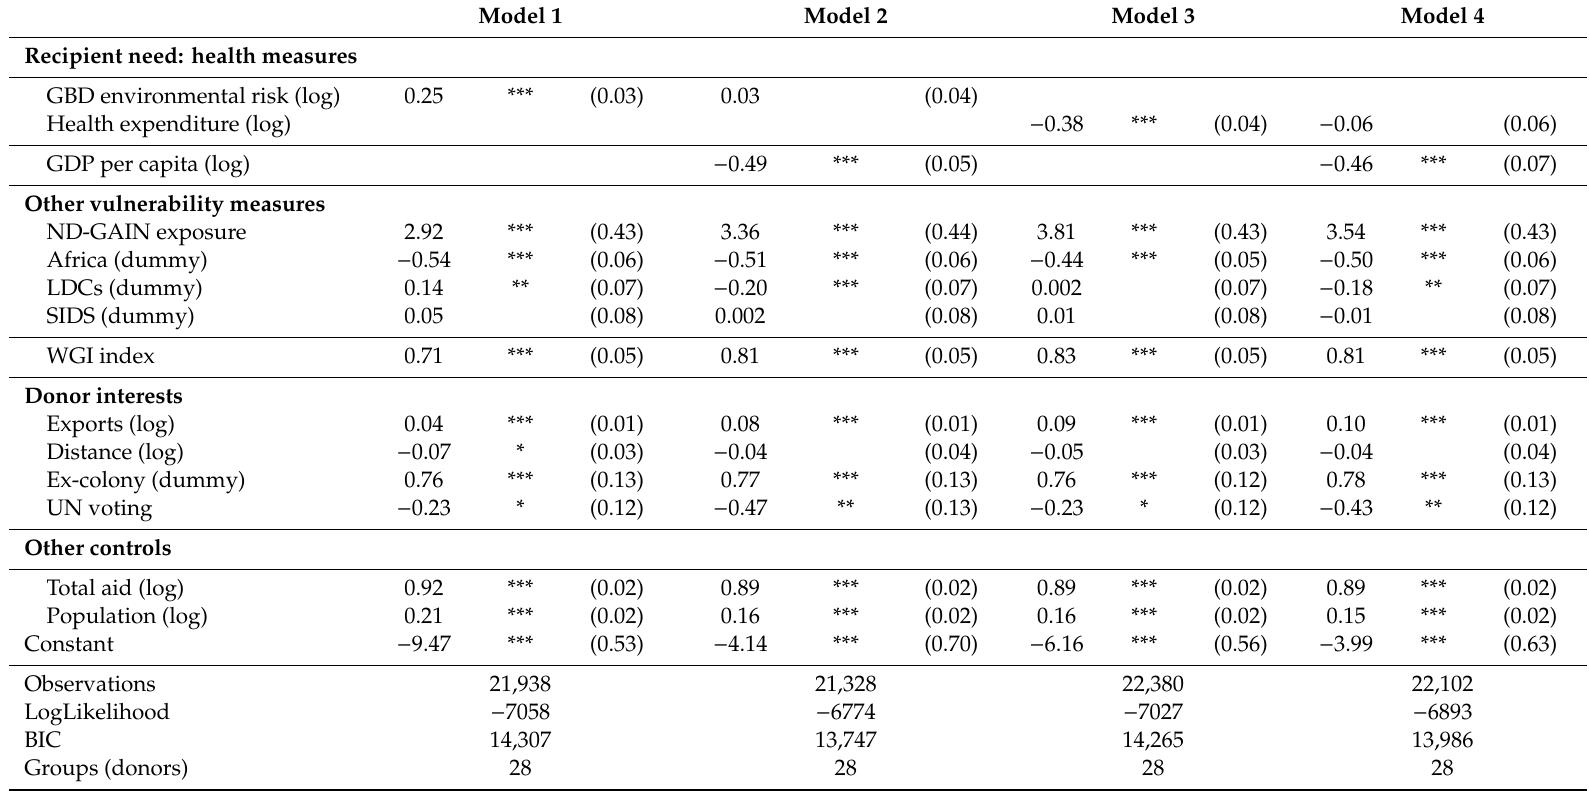
Table 2. E ff ects of health (and other) measures on the likelihood of receiving adaptation aid. Model 1 Model 2 Model 3 Model